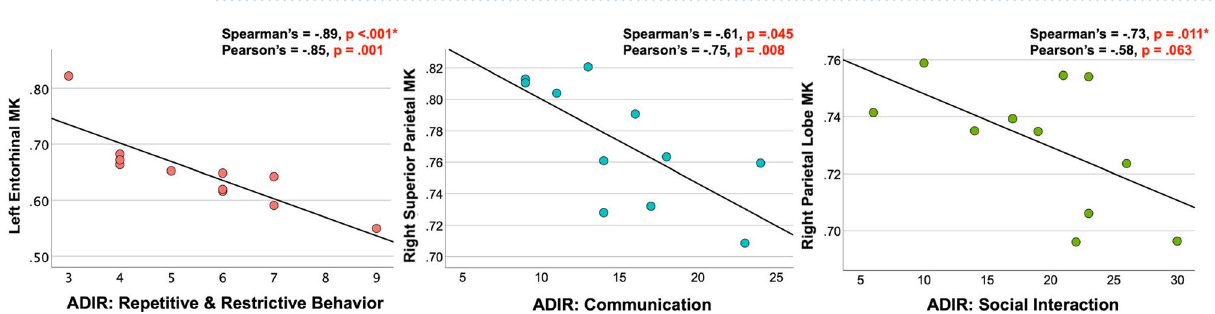
Figure 3. Brain areas with significant associations between performance on the 3 sub-categories of the ADI-R and mean kurtosis in the ASD group. A lower score on the ADI-R indicates less severe symptoms and is associated with increased MK in ASD. The strength of the correlation and the corresponding p value are listed for both Spearman’s and Pearson’s tests for each